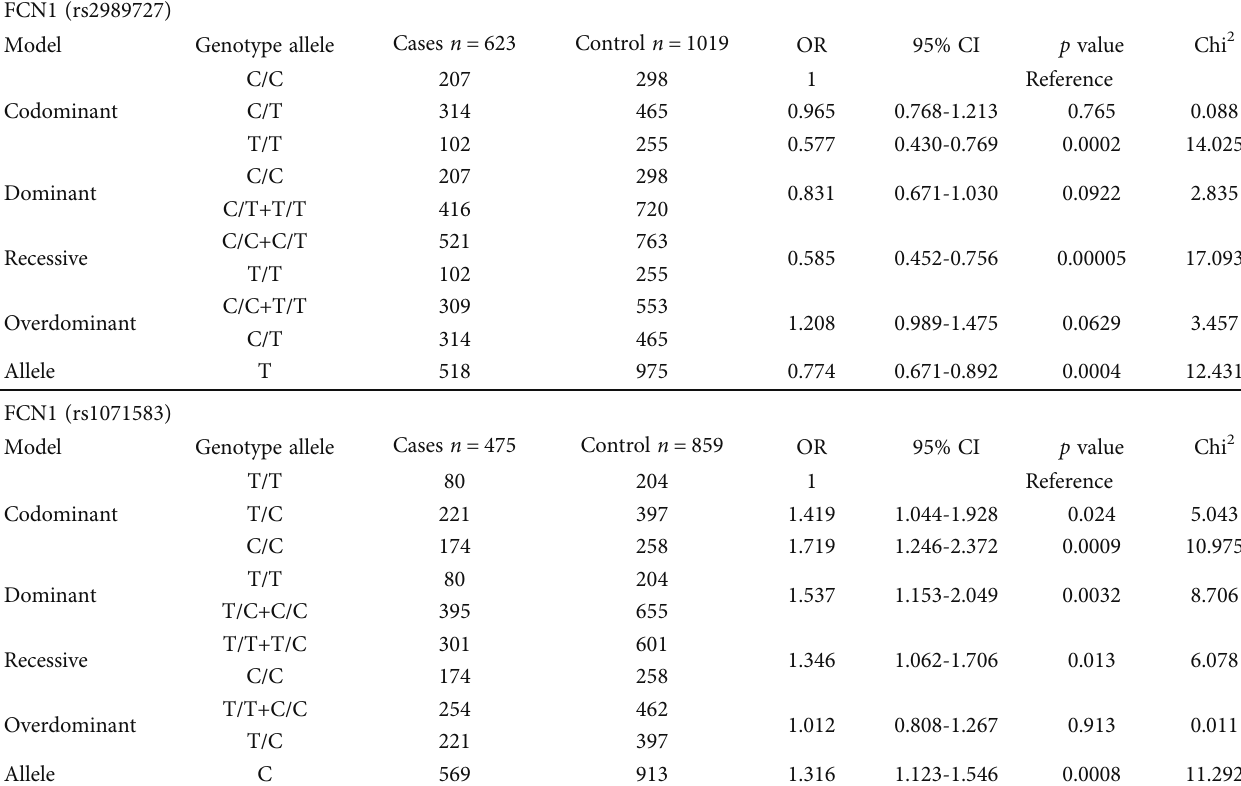
Table 4: Genotype and allele distributions of variants FCN1 gene in cases and control